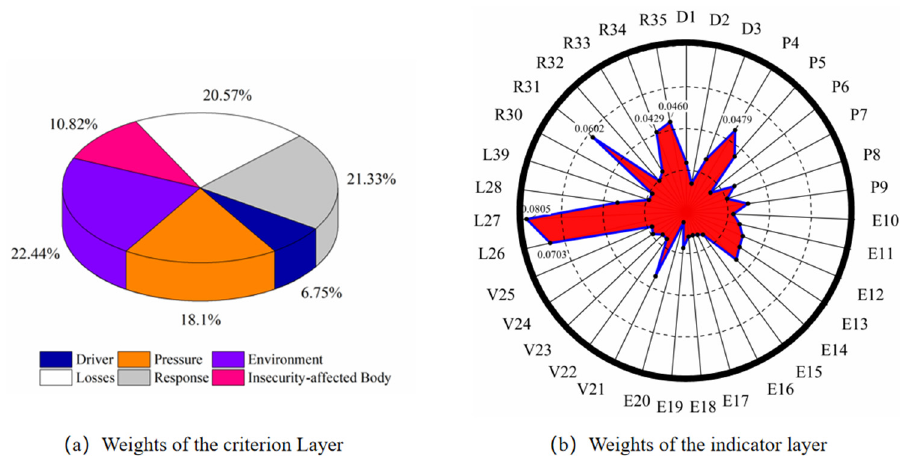
Figure 5. Chart of calculation results of Chongqing water security evaluation index weights.